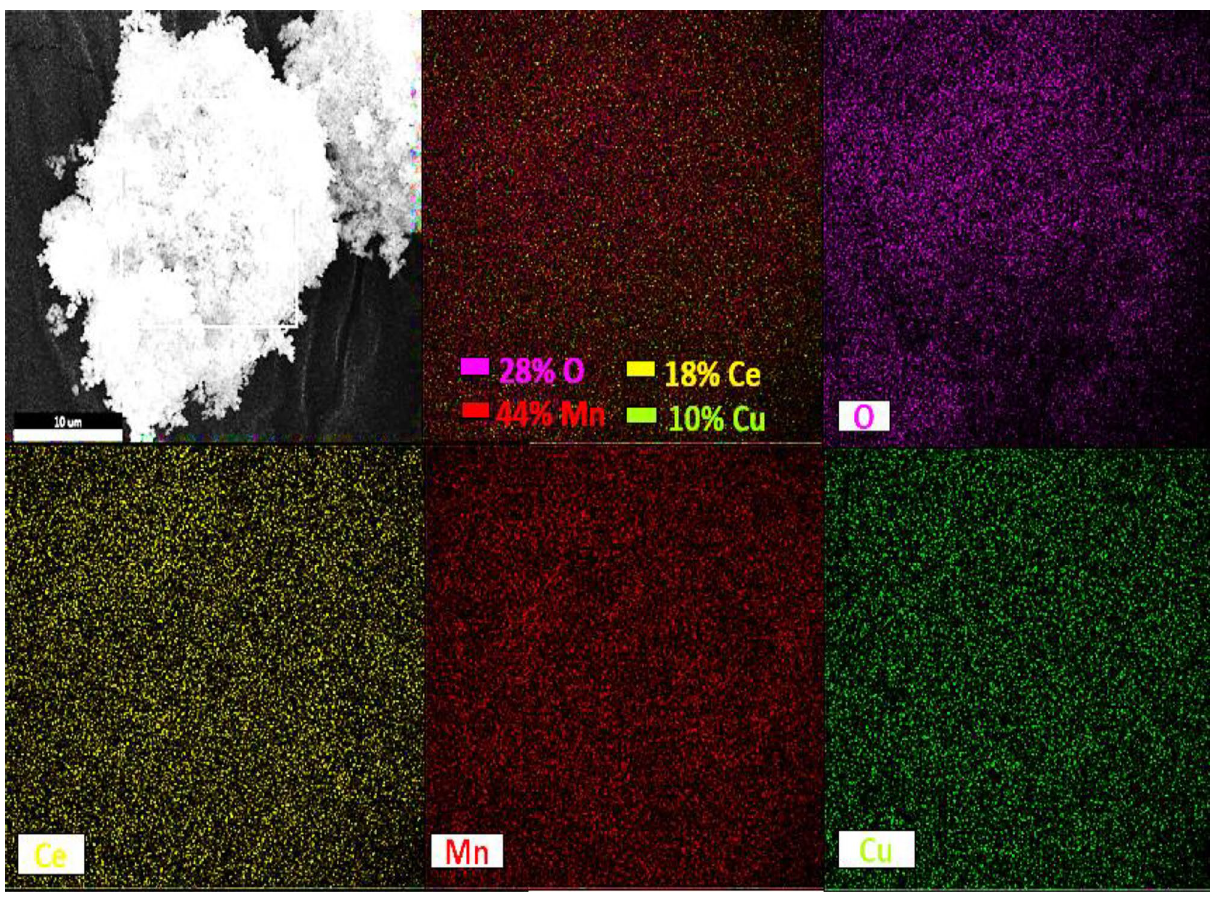
Figure 6. Elemental mapping of